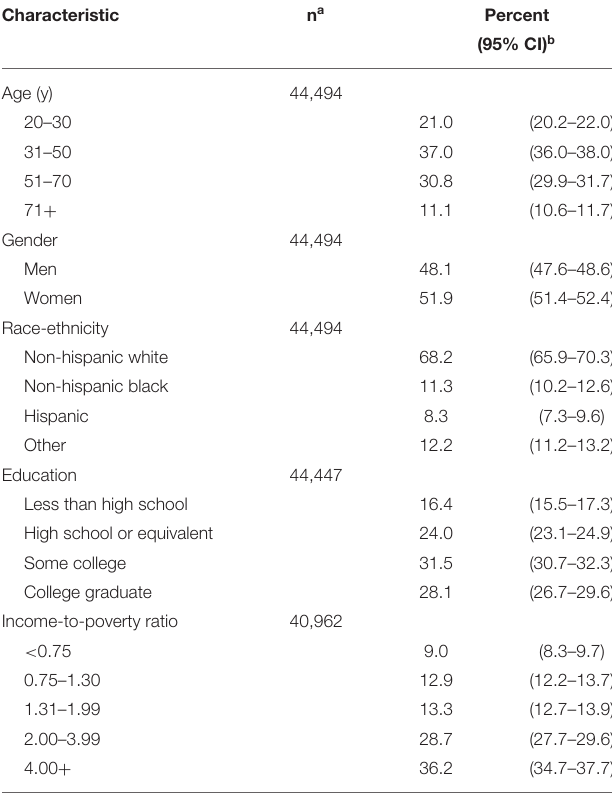
TABLE 1 | Characteristics of study sample, 2001–2018 ( n =